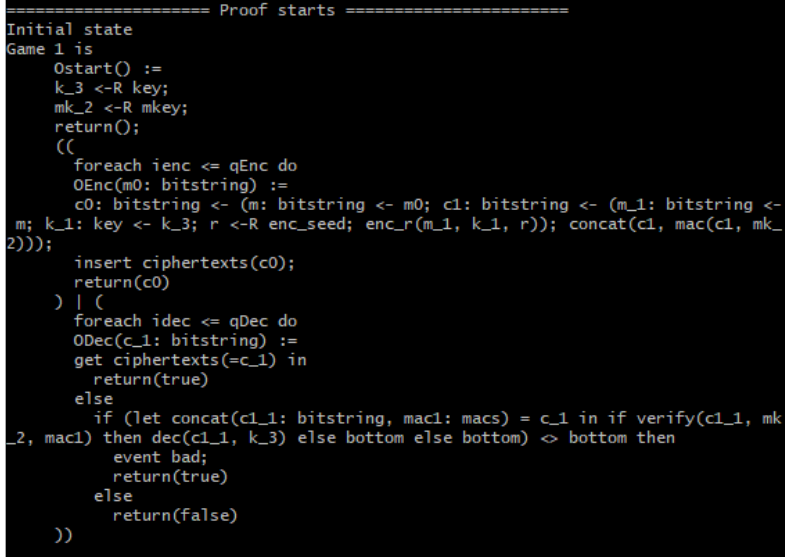
Figure 13. First Game of Verifying the INT_CTXT Property of Platoon Key Update Phases.